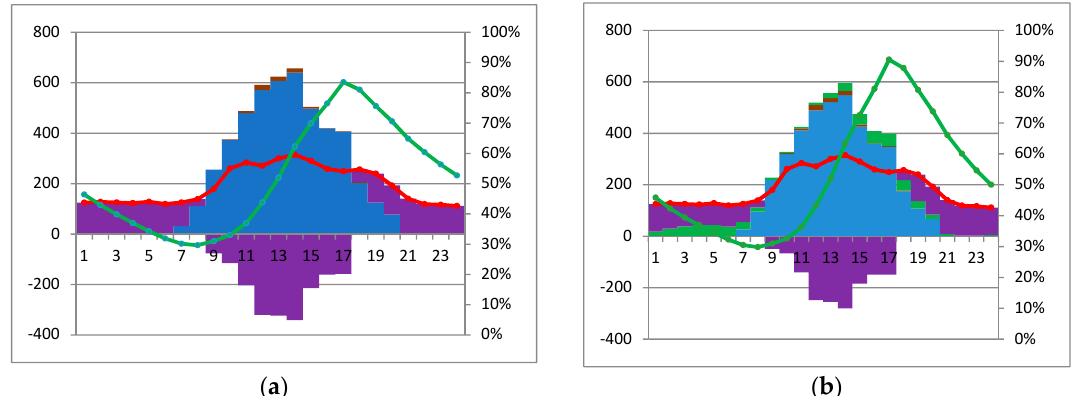
Energies 2019 , 11 , x FOR PEER REVIEW Figure 9. Day 5, 04/06/2009: Energy balance ( a ) without and ( b ) with tidal energy. Figure 9. Day 5, 04 / 06 / 2009: Energy balance ( a ) without and ( b ) with tidal energy.